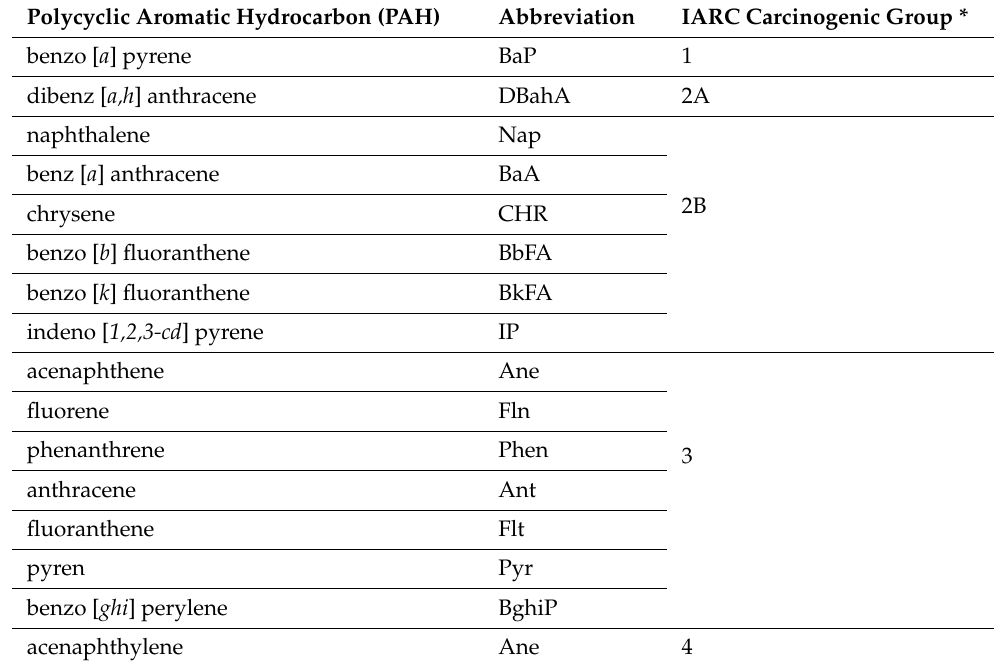
Table 2. List of analysed PAHs and designated abbreviations and IARC [38] classification. Polycyclic Aromatic Hydrocarbon (PAH)